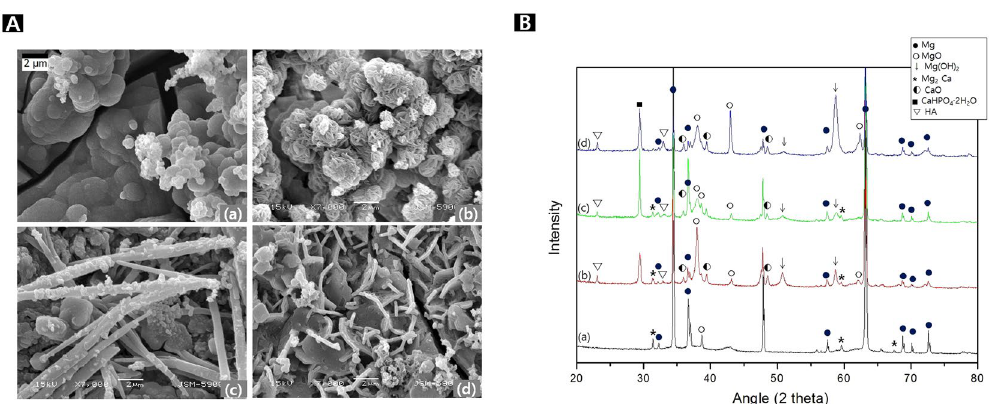
Figure 5. Surface morphologies ( A ) and XRD patterns ( B ) after immersion in Hank’s solution for 7 days (a) after anodization, (b) Ca deposition post anodization, (c) hydrothermal treatment at 120 °C, and (d) hydrothermal treatment at 150